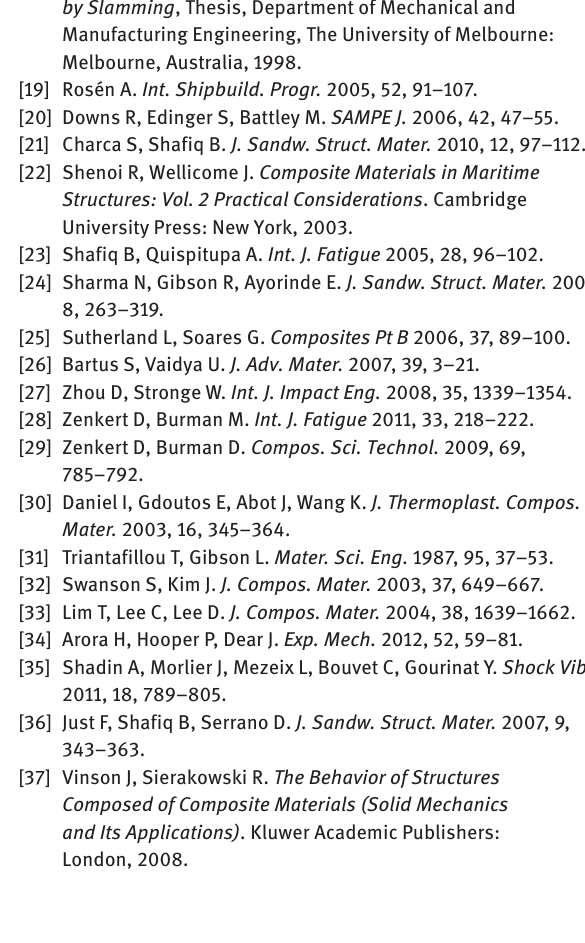
E. Figueroa and B. Shafiq: Shift in failure modes in sandwich